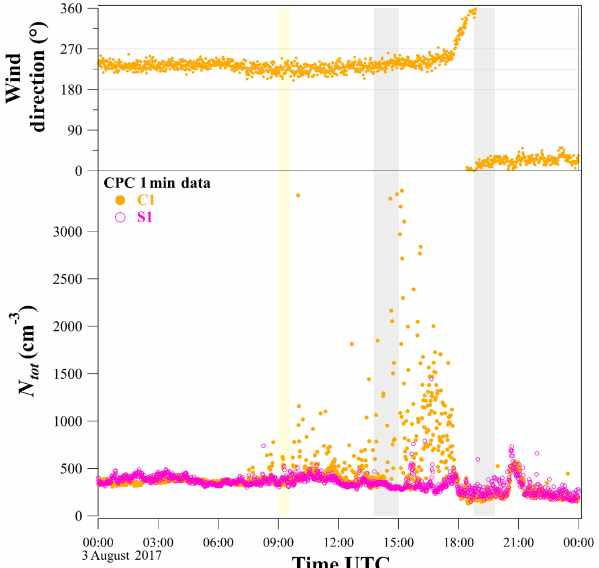
Figure 6. N tot and wind direction at C1 (orange) and S1 (pink) on 3 August 2017. Yellow and gray periods indicate when the AOS cameras observed trucks on the runway (yellow) and planes near the terminal building (gray).